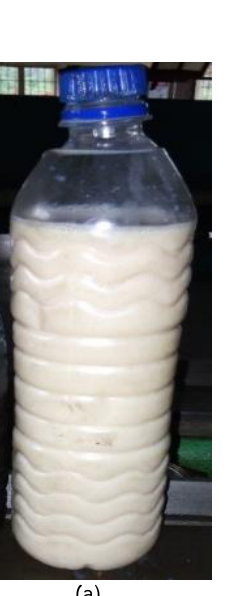
Figure 3: Experimental set up for machining process